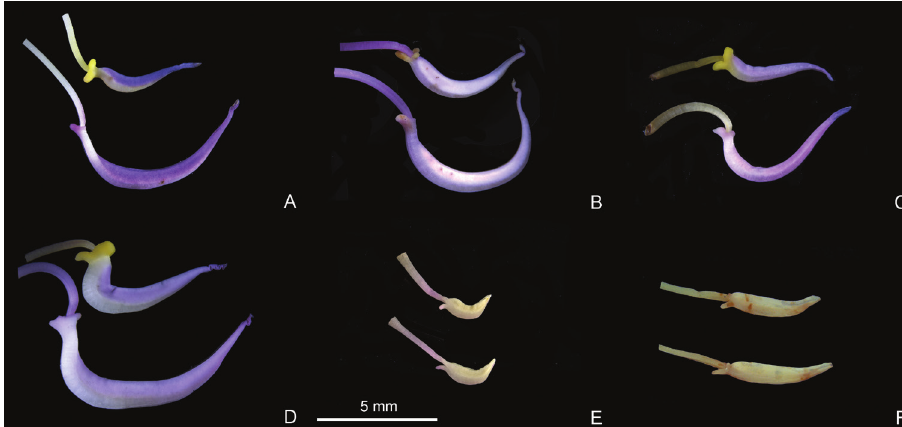
Figure 6. Stamen morphology in the Tashiroea clade. A–D Dimorphic stamens: A T. amoena ( Y. Liu 571 ) B T. quadrangularis ( Y. Liu 585 ) C T. biglandularis ( Y. Liu 553 ) D T. sinensis ( Y. Liu 569 ). E–F Iso- morphic stamens: E T. nudipes ( Y. Liu 435 ) F T. oligotricha ( Y. Liu 468 ). Scale bar: 5